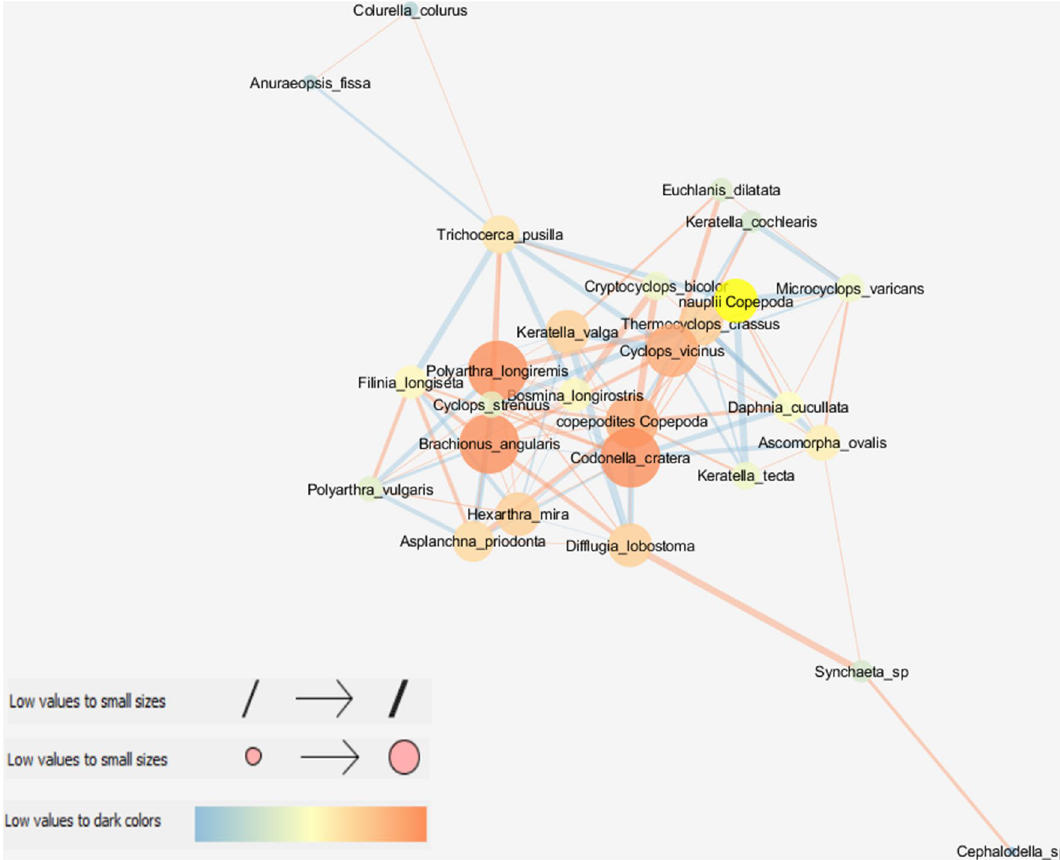
Figure 1. Network graph analysis of the interactions between zooplankton species in the HT class with node closeness centrality (NCC), node betweenness centrality (NBC) and edge betweenness centrality (EBC). Node size is proportional to the NCC measure; node color ranging from blue (dark) to orange (bright) is proportional to the NBC measure; edge thickness is proportional to the EBC measure. Sign of the relationship: a bright orange edge denotes positive relations between nodes, while a dark blue edge represents negative